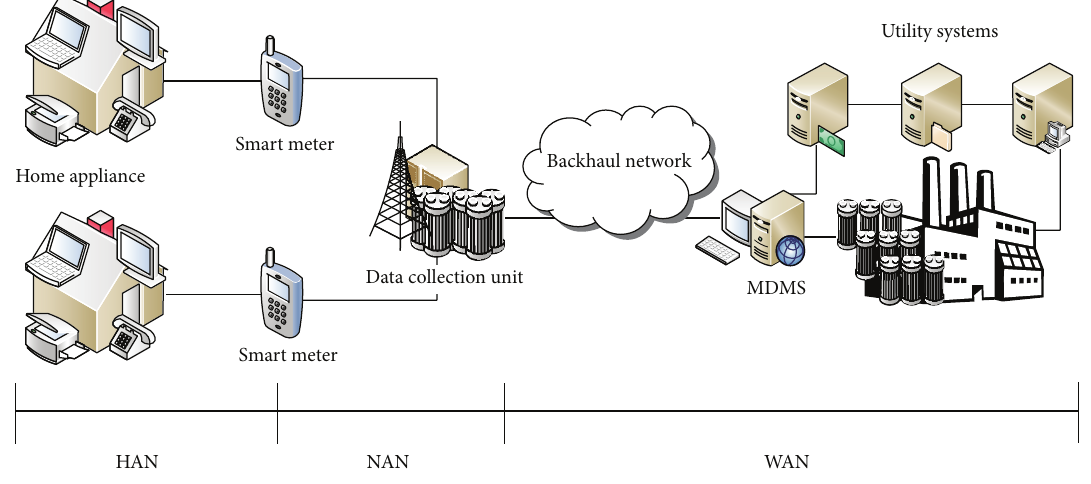
Figure 1: Overview of AMI